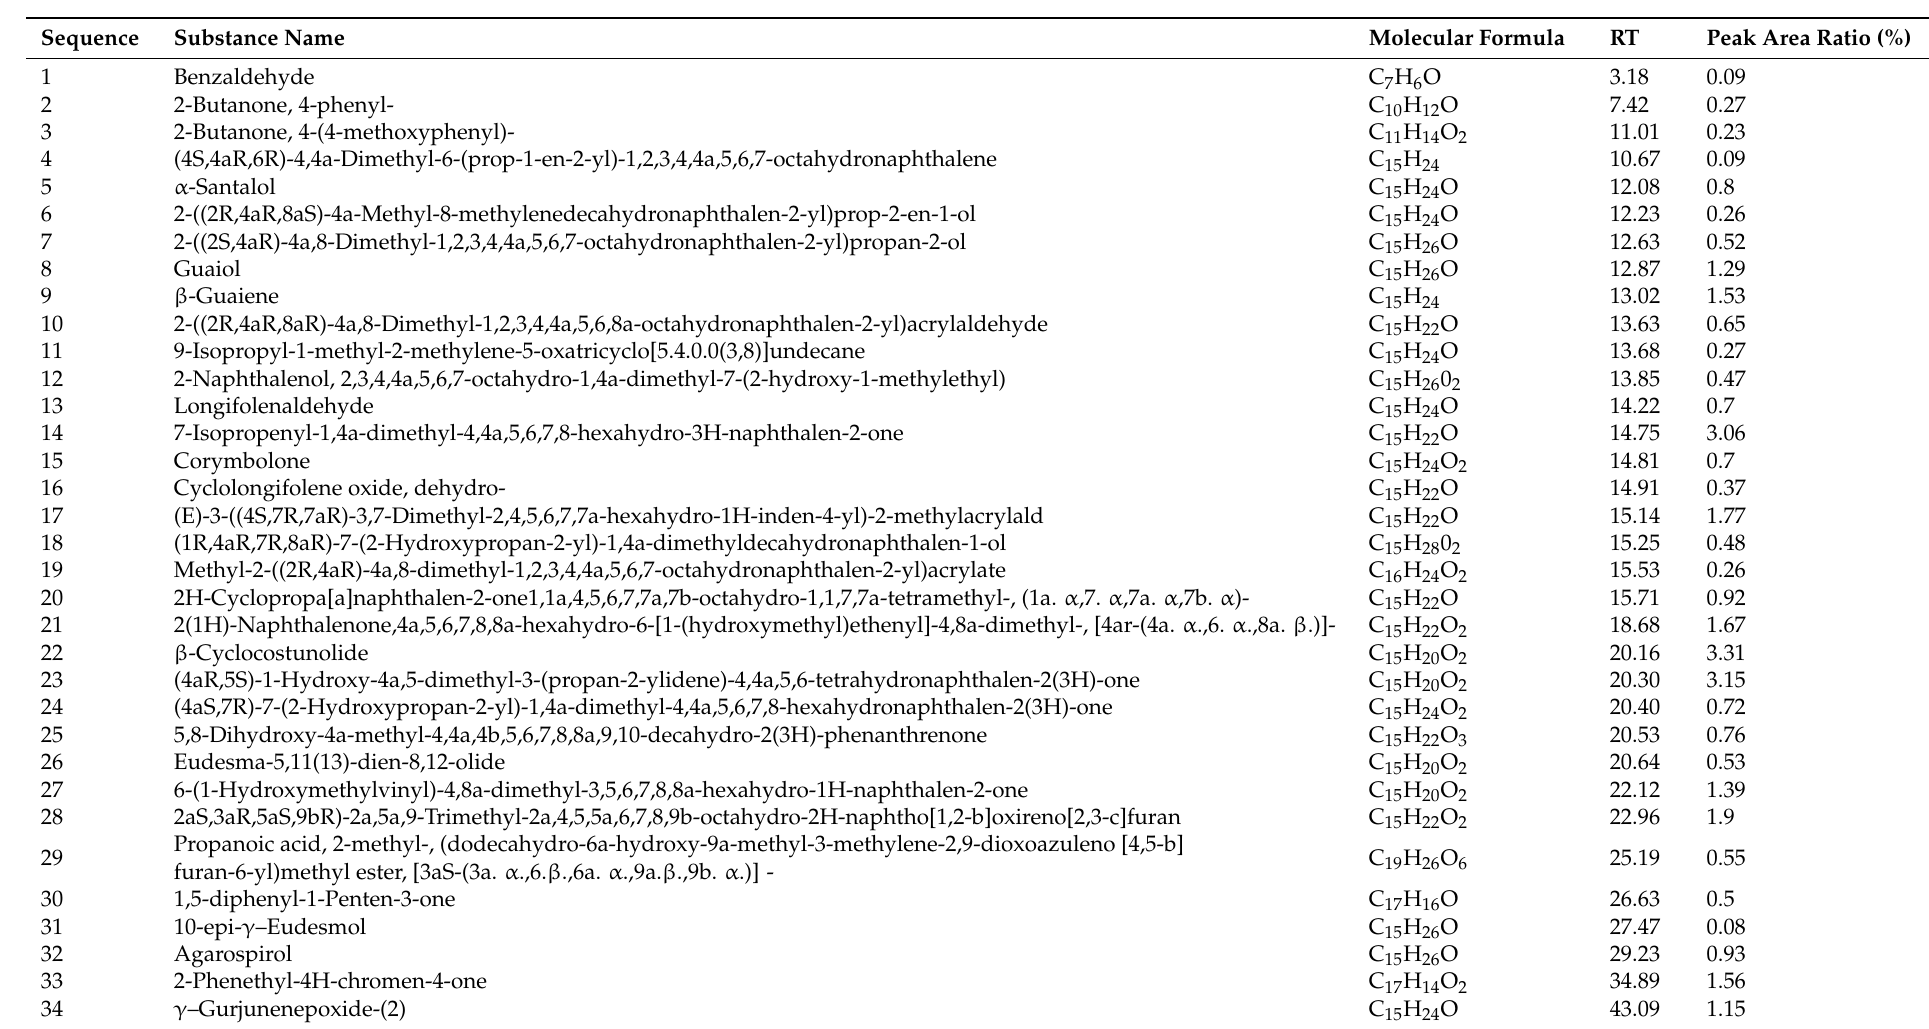
Table 1. Chemical composition of the AEO of